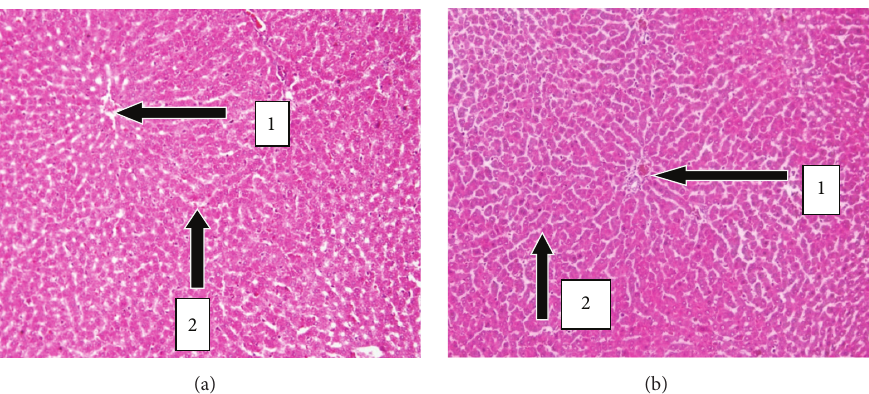
Figure 2: H&E stained section of livers at 20x magnification. (a) Liver sections of control rat showing normal histology. Note the presence of the central vein with no congestion and cellular infiltration (1) and sinusoids with no dilatation (2) . (b) Liver sections of treated male SD rats (2000mg/kg) with normal central vein, sinusoids, and hepatocytes.